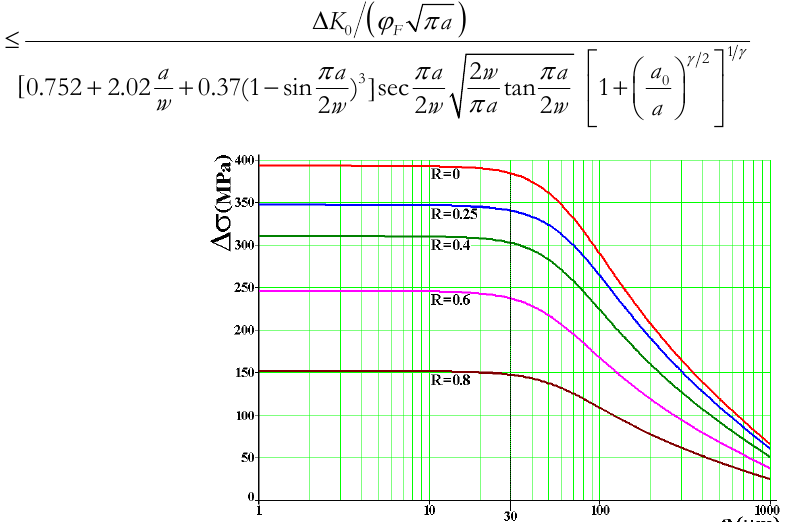
Figure 4: Larger stress ranges tolerable under several R –ratios by the analyzed component considering it contains an edge crack with size a , for w  3 .4mm ,   1 .12 ,  K